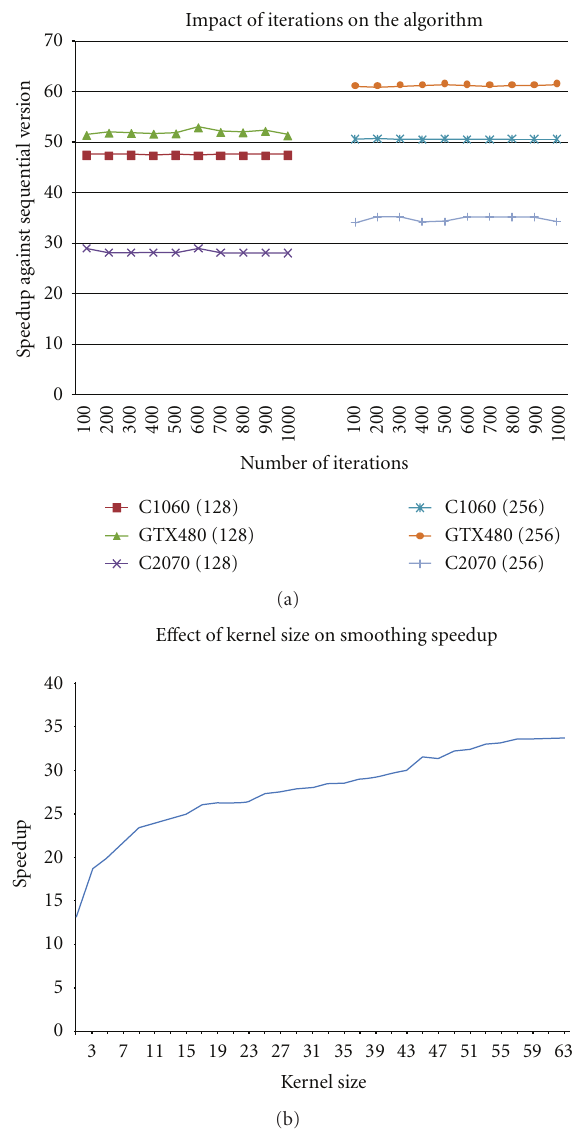
Figure 5: (a) shows the impact of number of iterations in the overall speed up of the algorithm. We show the impact for two di ff erent image sizes. (b) shows the impact of kernel size on the overall speed up of the algorithm.